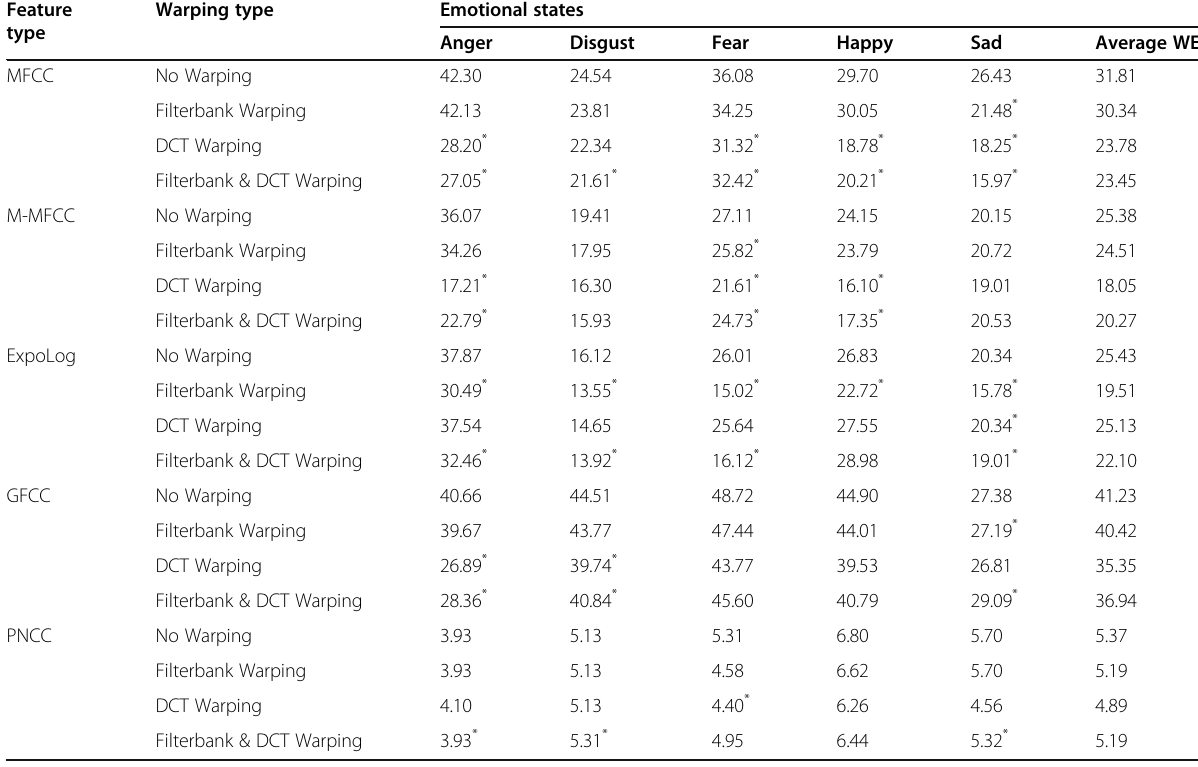
Table 4 The recognition performance of the proposed GMM-HMM EASR system (in terms of WER (%)) for Persian ESD. The values of WER are obtained by applying different warping methods to various acoustic features extracted from different emotional utterances. The symbol * shows statistically significant cases (i.e., p value <